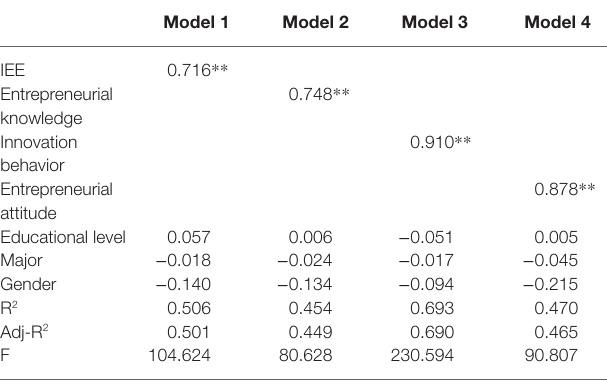
TABLE 7 | Regression analysis results (dependent variable : Entrepreneurial